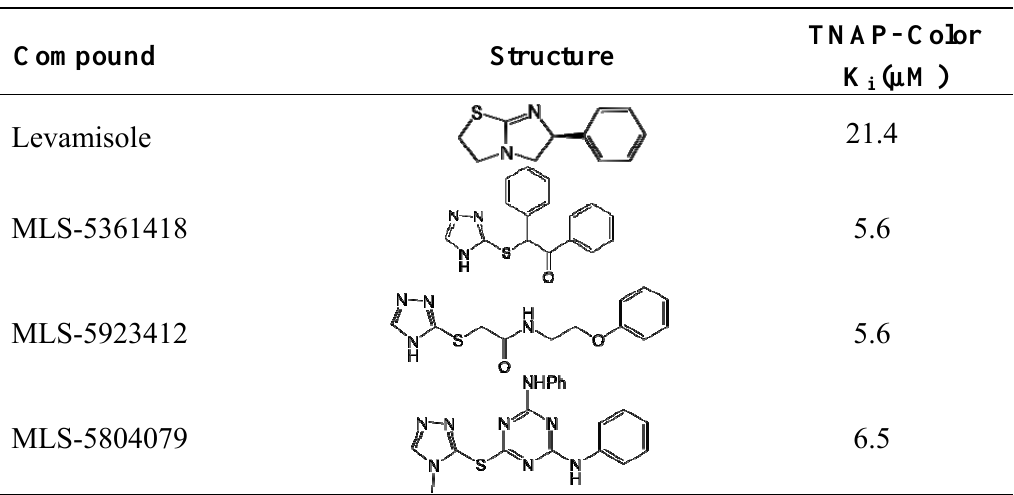
Table 1. In vitro data on existing inhibitors of